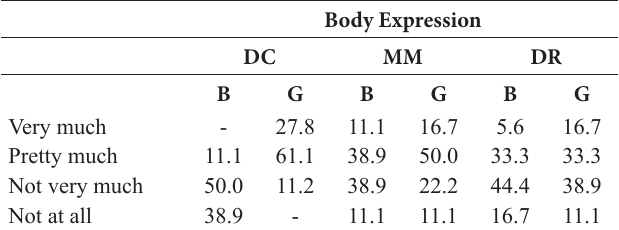
Table 5. Teachers’ opinions concerning boys’ (B) and girls’ (G) interest (in percentages) in body expression. DC = dancing, MM = mime, DR = dramatization ( n